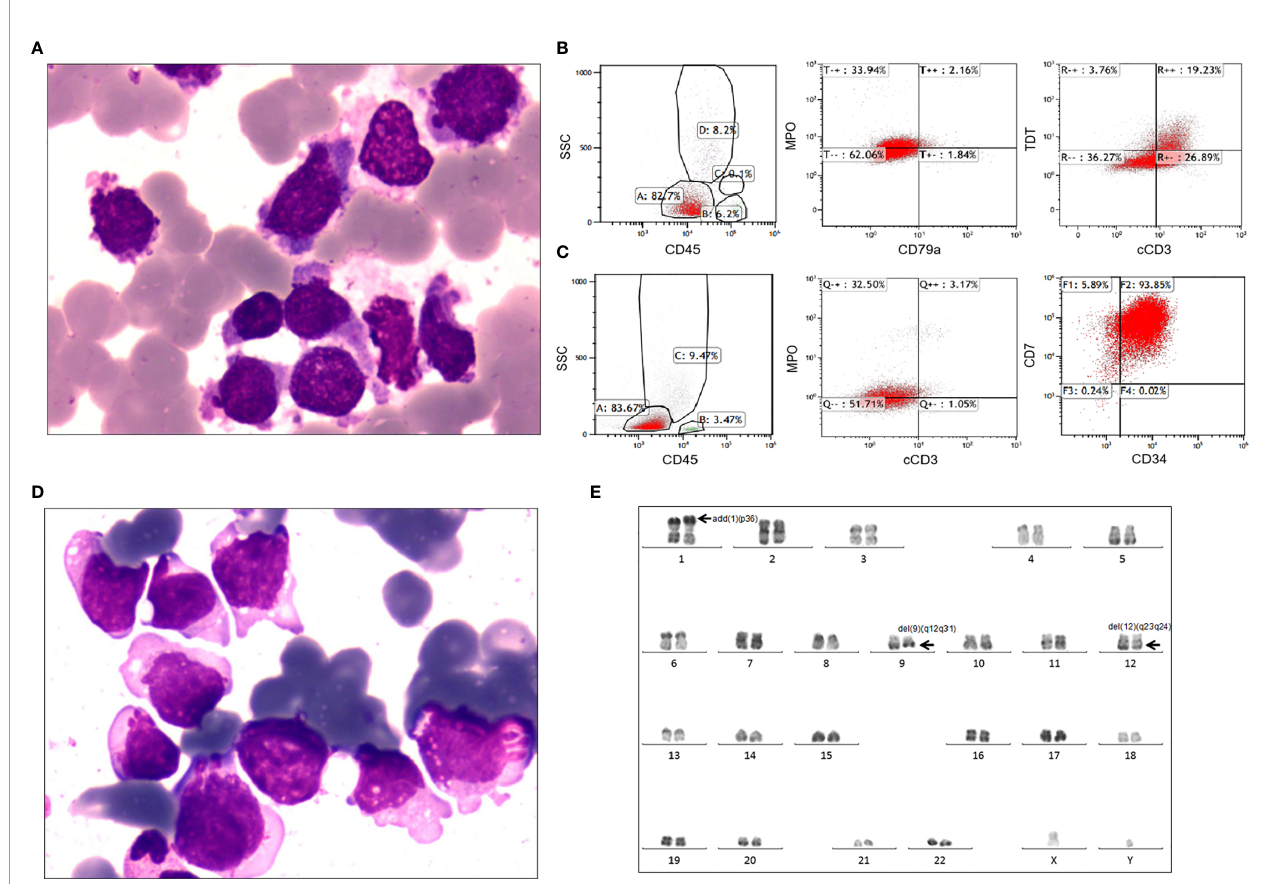
FIGURE 2 | Laboratory characteristics of the adult patient with T/M MPAL with the MED14 - HOXA9 fusion. (A) Bone marrow aspirate at diagnosis. Morphological analysis showed hypercellular marrow with increased blasts variable in both cell and nucleolus sizes and negative for POX staining. (Wright ’ s staining ×1,000). (B) Immunophenotyping of bone marrow cells at diagnosis. Flow cytometric analyses of leukemic cells revealed that the blast cells were positive for TDT, cCD3 and weak positive for myeloperoxidase (MPO), but negative for cCD79a. (C) Immunophenotyping of bone marrow cells at relapse. The blast cells were positive for CD34 and CD7 and weakly positive for MPO and cCD3. (D) Bone marrow aspirate at relapse. Morphological analysis showed 72.5% blasts in the bone marrow smear. (Wright ’ s staining ×1,000). (E) Karyotype analysis at relapse. R-banding analysis using the bone marrow sample revealed a karyotype of 46,XY,add(1)(p36),del(9)